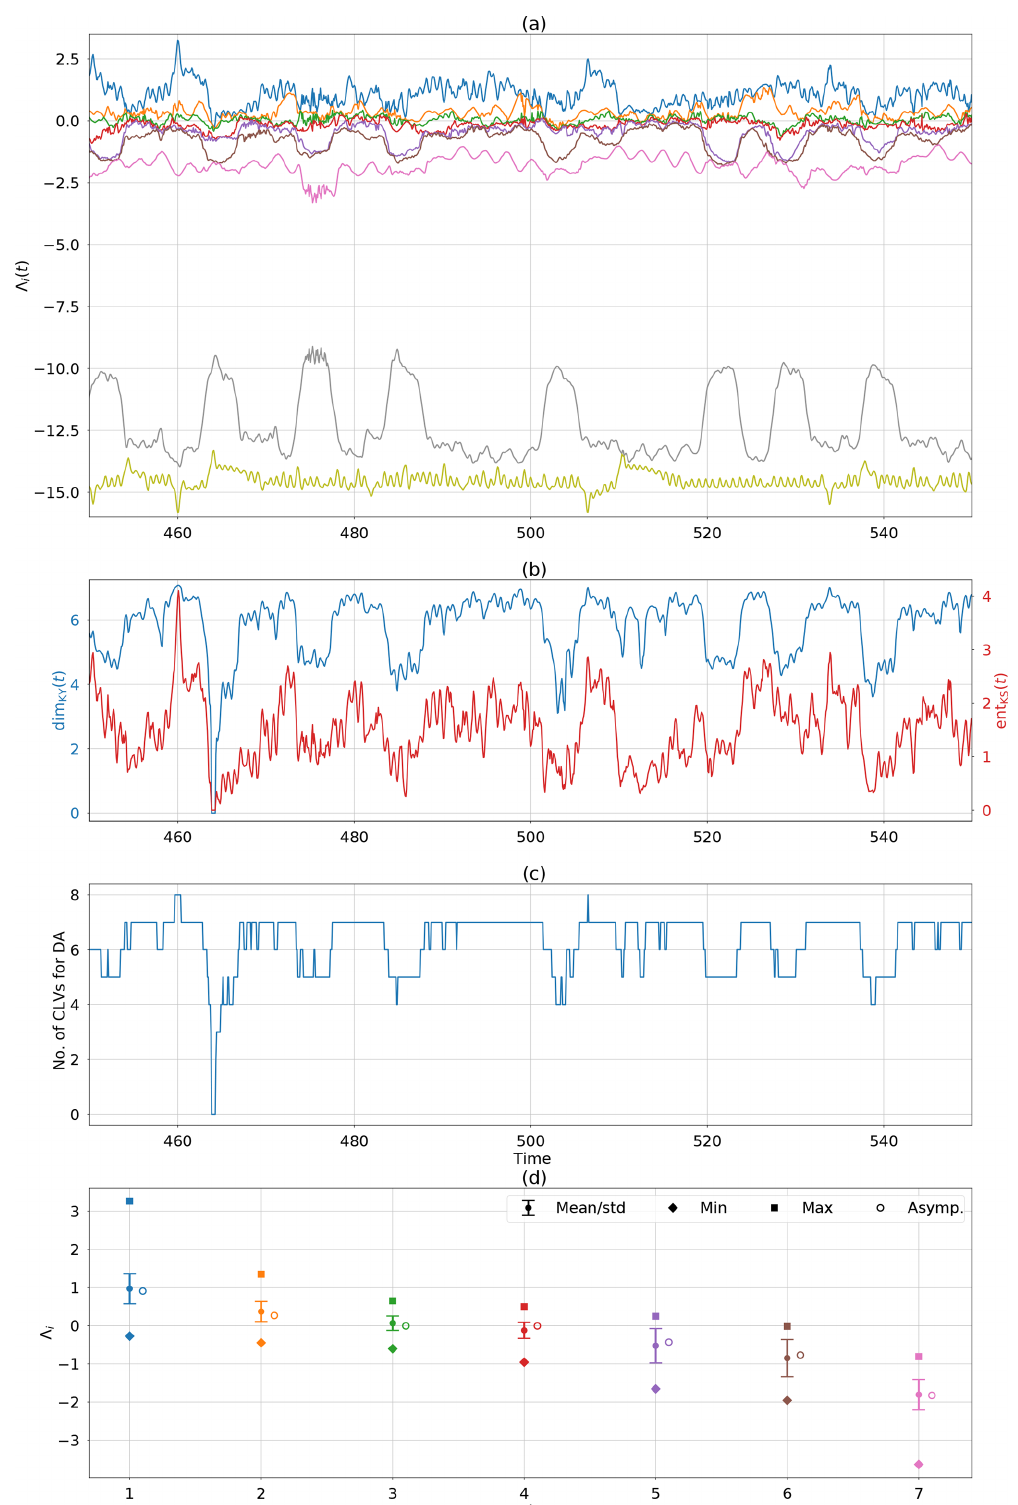
Figure 9. Local attractor properties of DA using the variable CLV method and benchmark observations ( y e ,y t ,Y ). (a) FTLEs calculated from the ensemble mean trajectory over a window of τ = 4. (b) Local Kaplan–Yorke dimension and Kolmogorov–Sinai entropy computed through Eqs. (2) and (3) using the FTLEs at the given time. (c) Rank of the covariance matrix. (d) Statistics of the first seven FTLEs compared to asymptotic